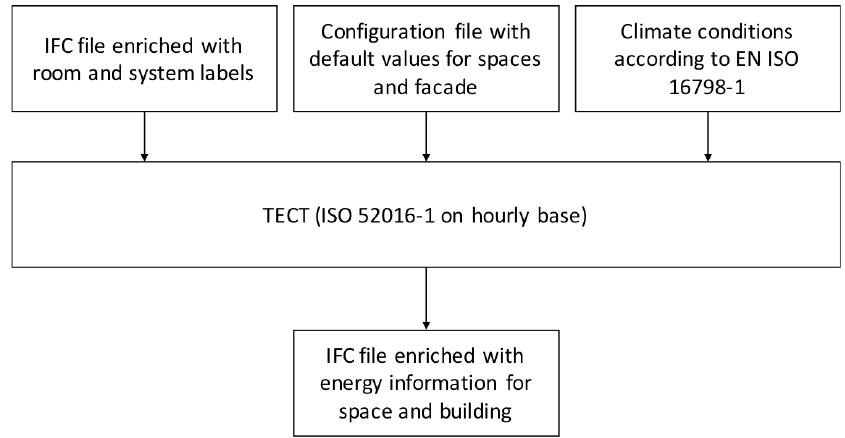
Figure 6. Input and output of